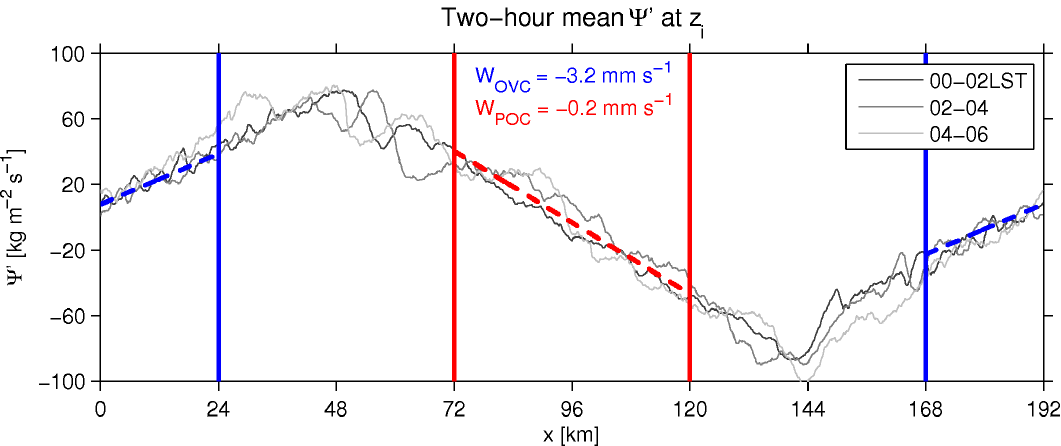
Fig. 14. Traces of magnitude for two-hour means of the y -averaged perturbation streamfunction Ψ 0 at the level of the domain-mean inversion. The y-averaged stream function at the nearest grid level to the domain mean Zi is calculated from each 3D model output (i. e. every ten minutes), and the plots average together two hours of these traces.